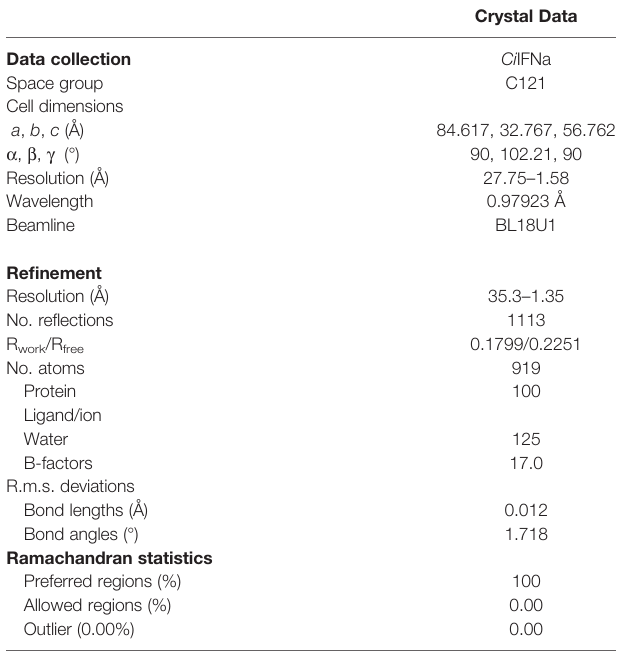
TABLE 2 | Data collection and re fi nement statistics (molecular replacement).